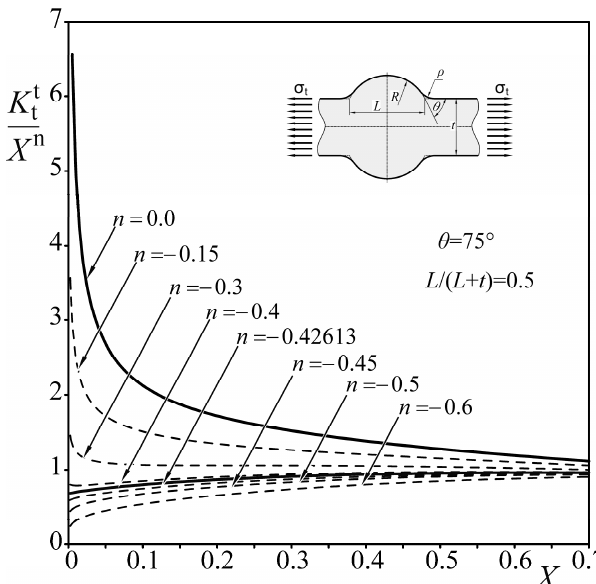
Figure 11. Influence of exponent n on the normalized K tt of a Double-V butt-welded joint under tension, when Y = 0.5 and θ = 75°.